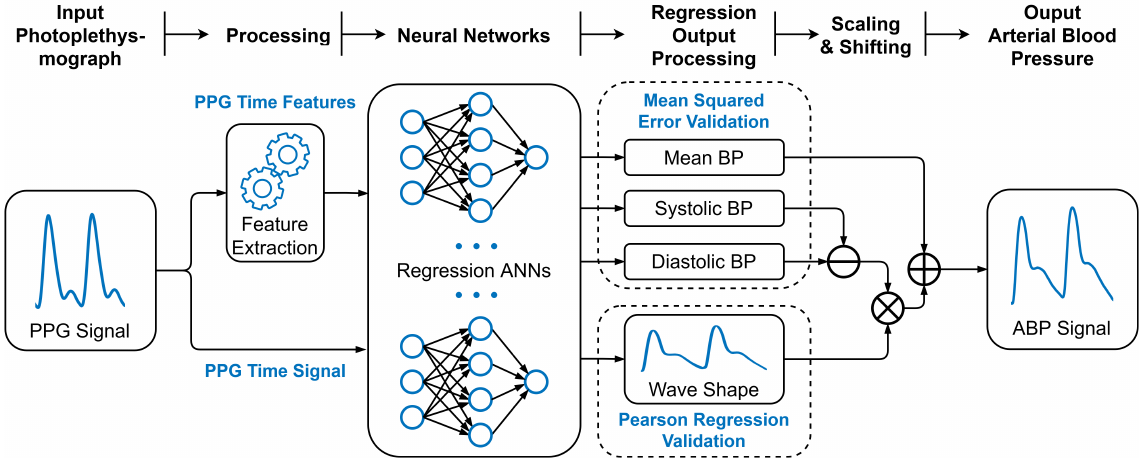
Figure 1. A block diagram depicting the overall system of determining the ABP waveform from the PPG